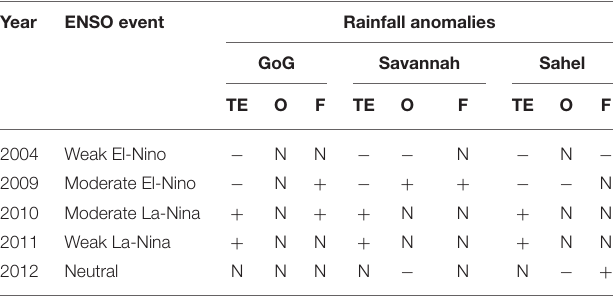
TABLE 3 | ENSO events and the observed rainfall anomalies as extracted from the 1st and 2nd top rows of Figures 2A , 7A,C,E .